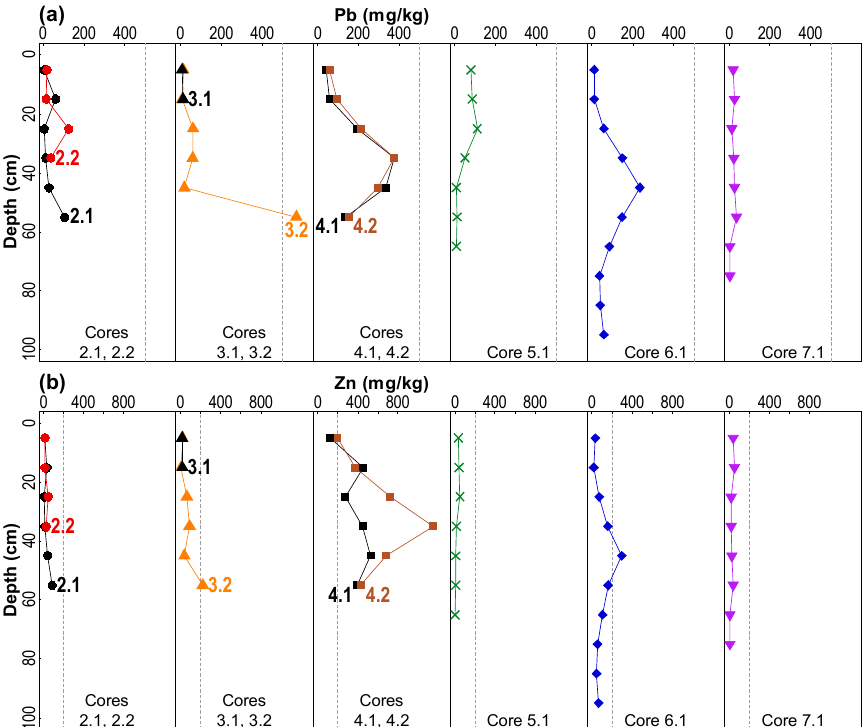
Figure 11. Depth profiles of ( a ) lead (Pb) and ( b ) zinc (Zn) in soil cores collected from Smith’s Lake and Charles Veryard Reserves, City of Vincent, Western Australia. Core locations from Figure 1. Ecological investigation limits (EIL) are shown as vertical dashed lines where relevant.